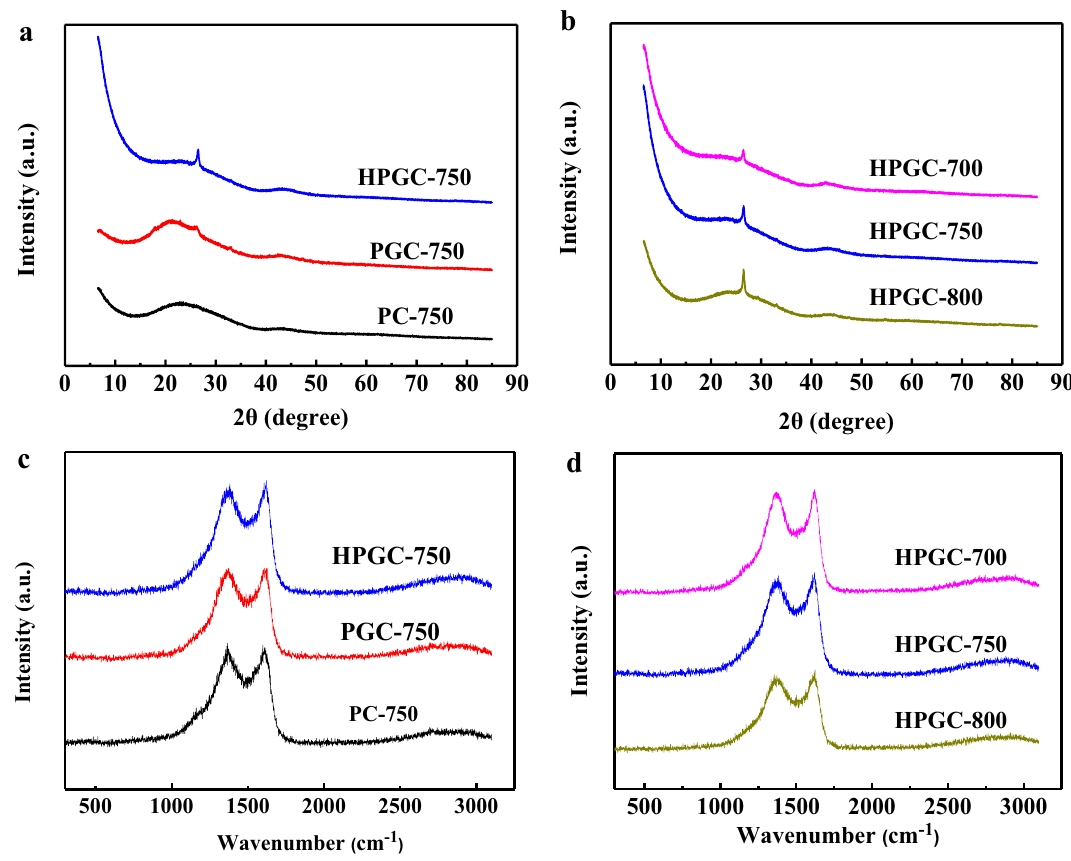
Figure 4. ( a ) XRD patterns and ( c ) Raman spectra of PC-750, PGC-750, and HPGC-750; ( b ) XRD patterns and ( d ) Raman spectra of HPGC- T